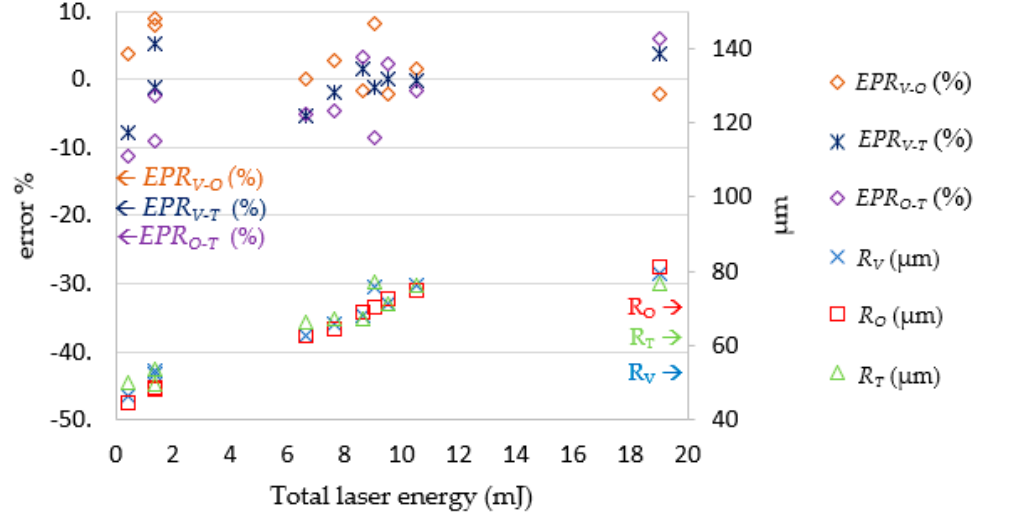
Figure 19. Comparison of R V , R T , and R O . Note: EPR V-O = ( R V − R O )/ R O (%); EPR V-T = ( R V − R T )/ R T (%); EPR O-T = ( R O − R T )/ R T (%).